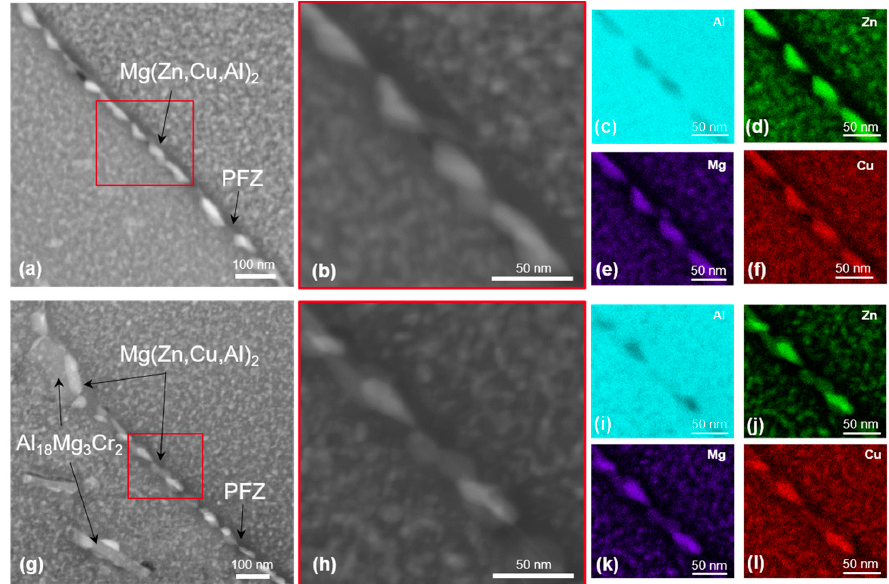
Figure 10. STEM dark-field images and EDX maps of alloys in T76 state: ( a – f ) 7449 and ( g – l ) 7449+Cr. The red boxes indicate the region of interest for EDX mapping.